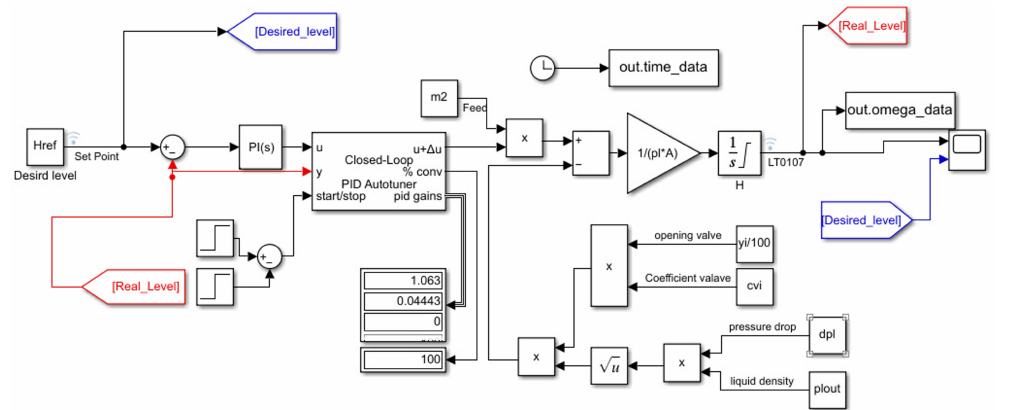
Figure 8. Overall system with closed-loop PID